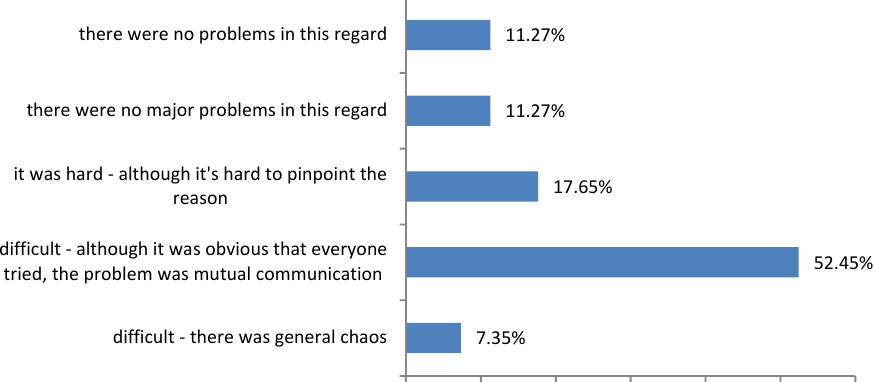
Figure 2. Problems related to the need to switch from the traditional to the remote form of work. People are the most important element of the information system. Its effectiveness depends on them. Therefore, the respondents were asked about the impact of a sudden and forced transition to remote work on professional relationships in the enterprise (Figure 3).